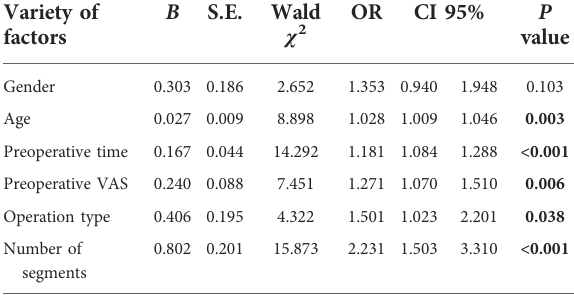
TABLE 3 Multivariate logistic analysis for delayed